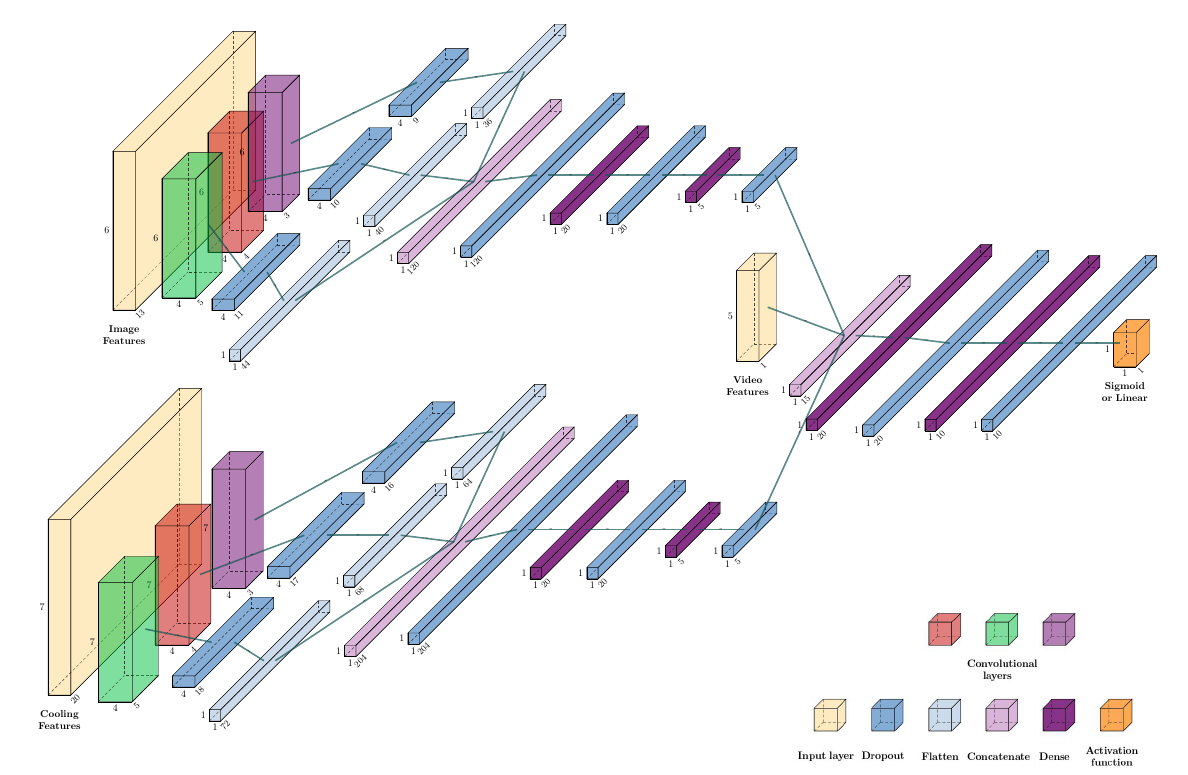
Figure 3. The architecture of the conceived CNN adapted for classification and regression